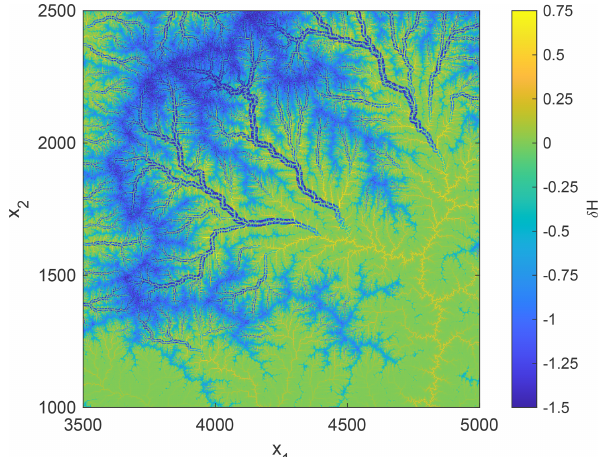
Figure 10. Change in surface height compared to the initial flu- vial topography (black square in Fig. 3) obtained from the shared stream-power model at the time when the ELA reaches H e = 8.